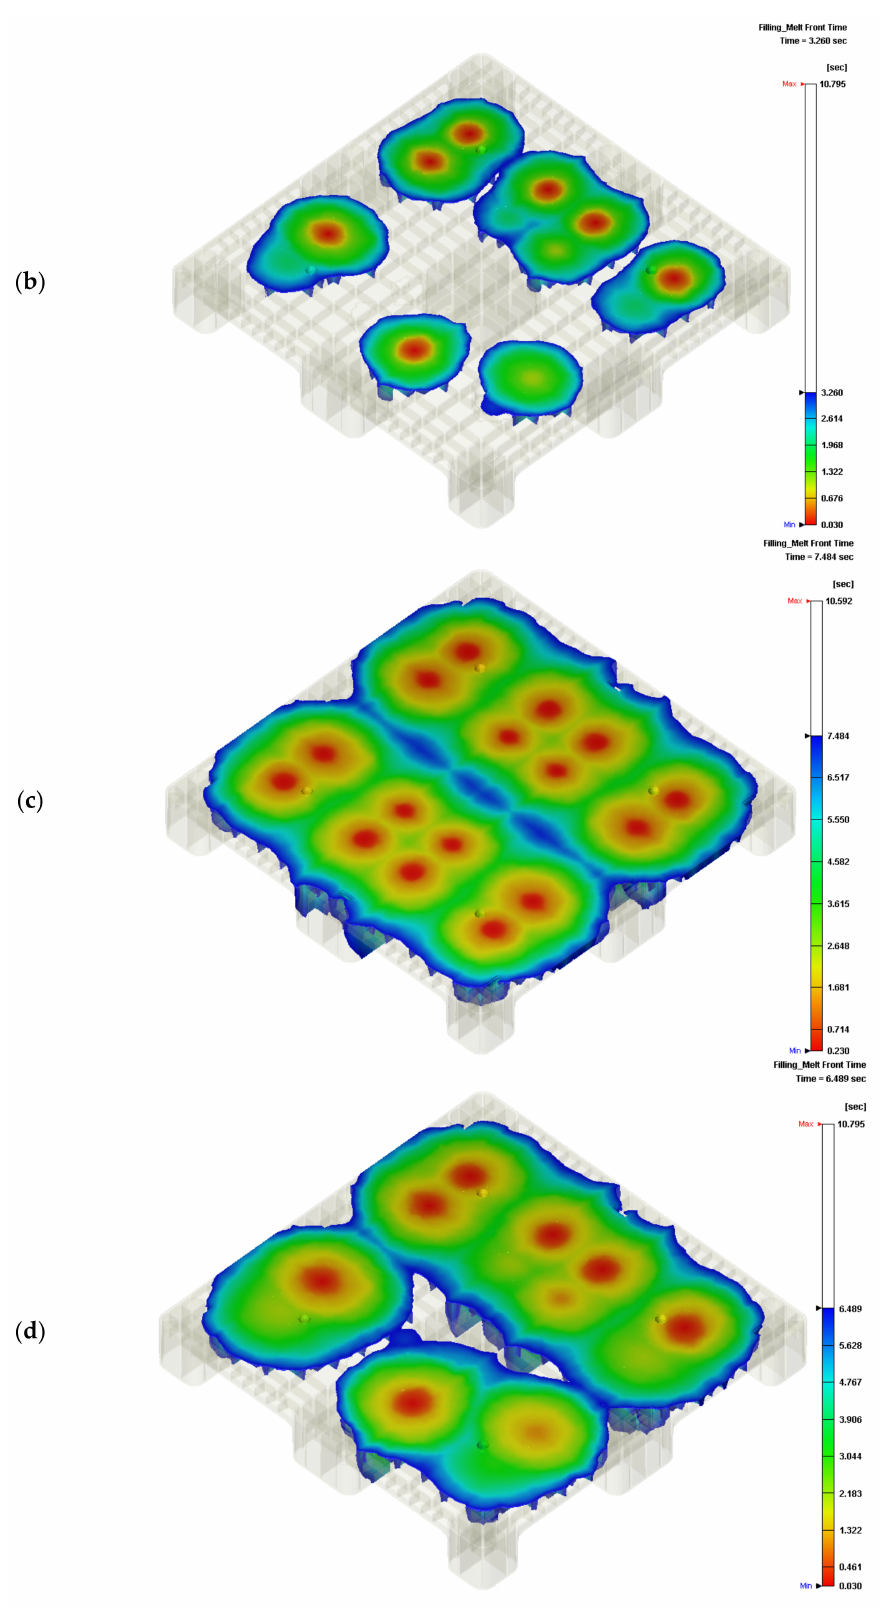
Figure 2. Flow fronts in short-shot testing: ( a ) 30% flow front under the concurrent valve gate-opening scheme; ( b ) 30% flow front under sequential valve gate-opening scheme; ( c ) 60% flow front under concurrent valve gat- opening scheme; ( d ) 60% flow front under sequential valve gate-opening